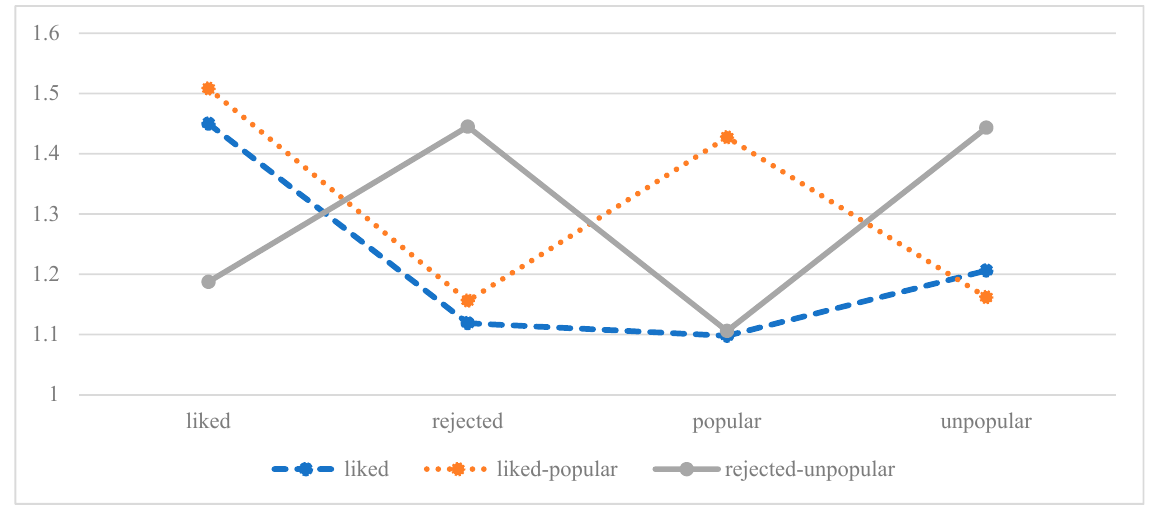
Figure 1. Three profile solution, abuse group.